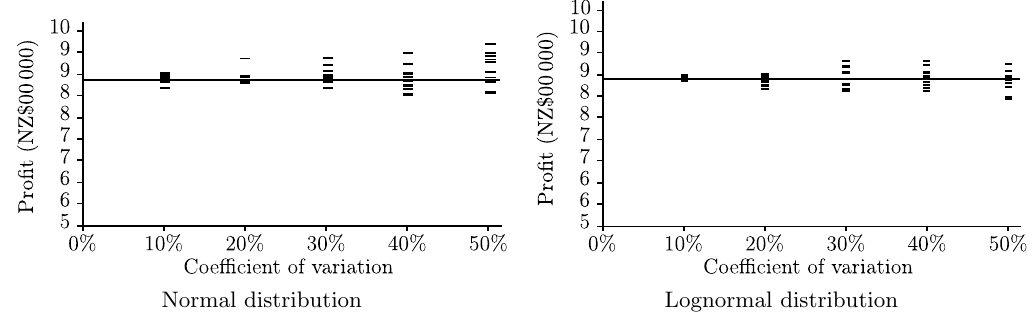
Figure 6: Fluctuation in the profit of a 10-period model of IFPM due to variability in catch rate with the mean decreased by